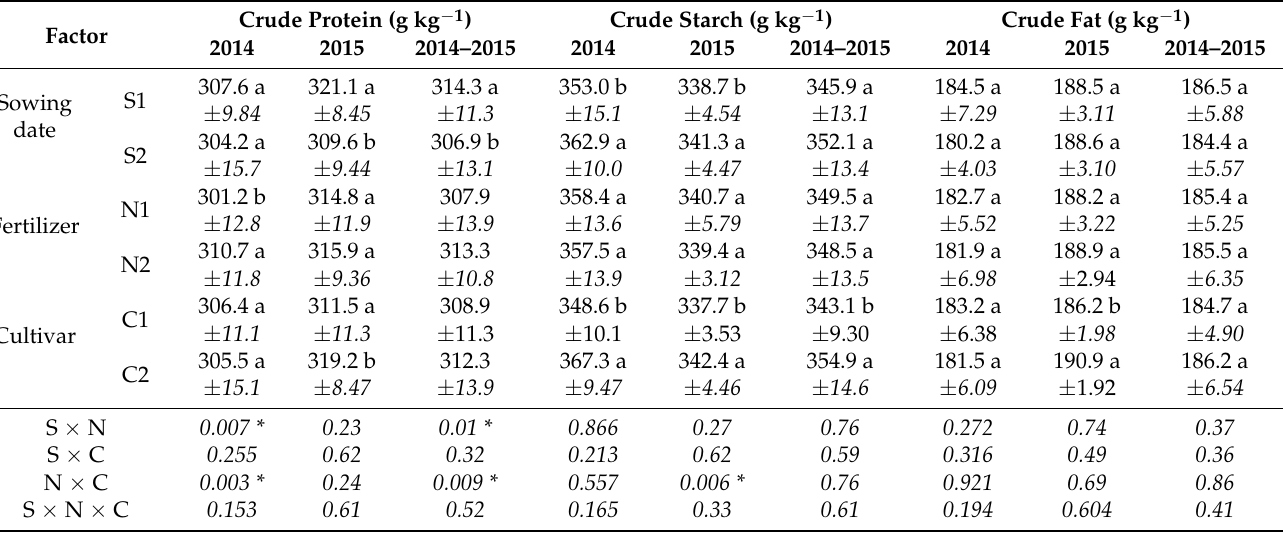
Table 4. Comparison of content (g kg − 1 ) of protein, starch and fat in soybean seeds depending on sowing date, fertilization and